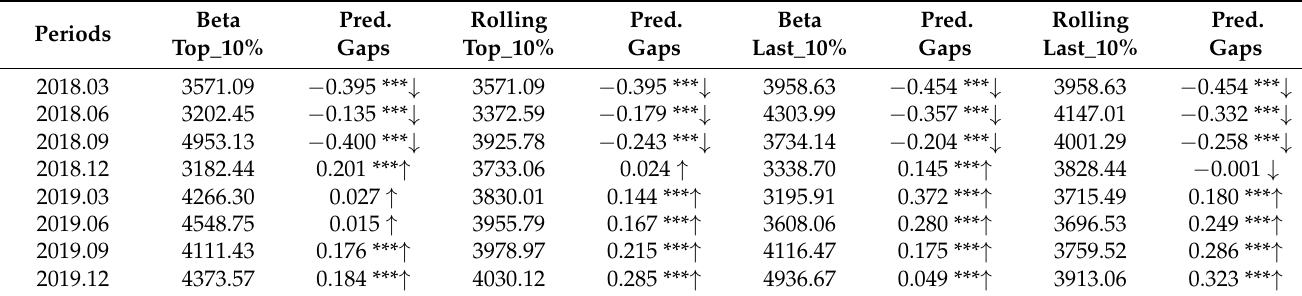
Table 8. Sensitivity results for